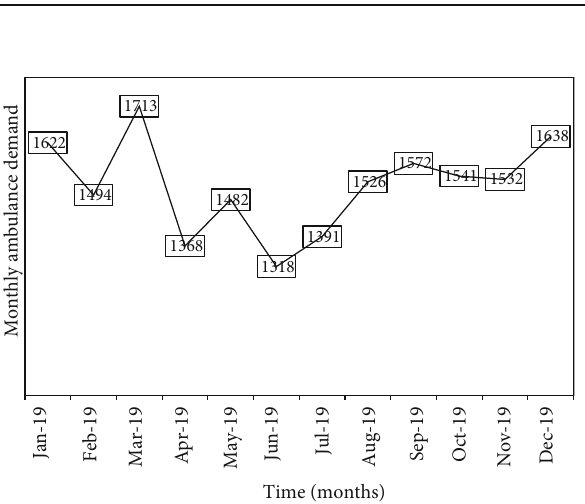
Figure 6: Public emergency ambulance demand forecast for 2019